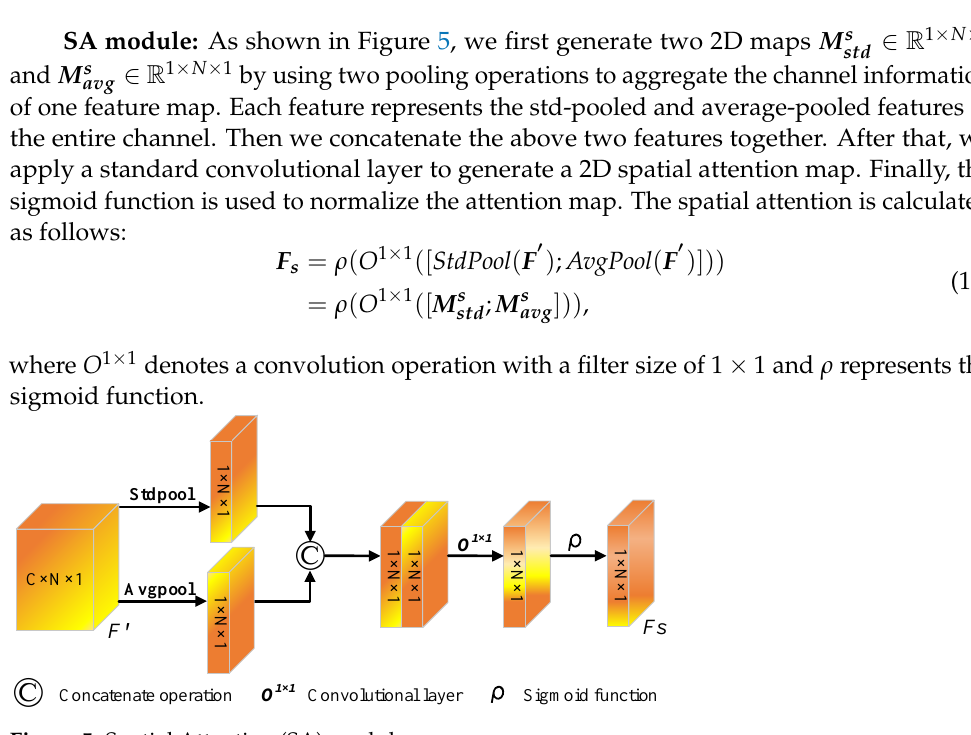
Figure 5. Spatial Attention (SA)